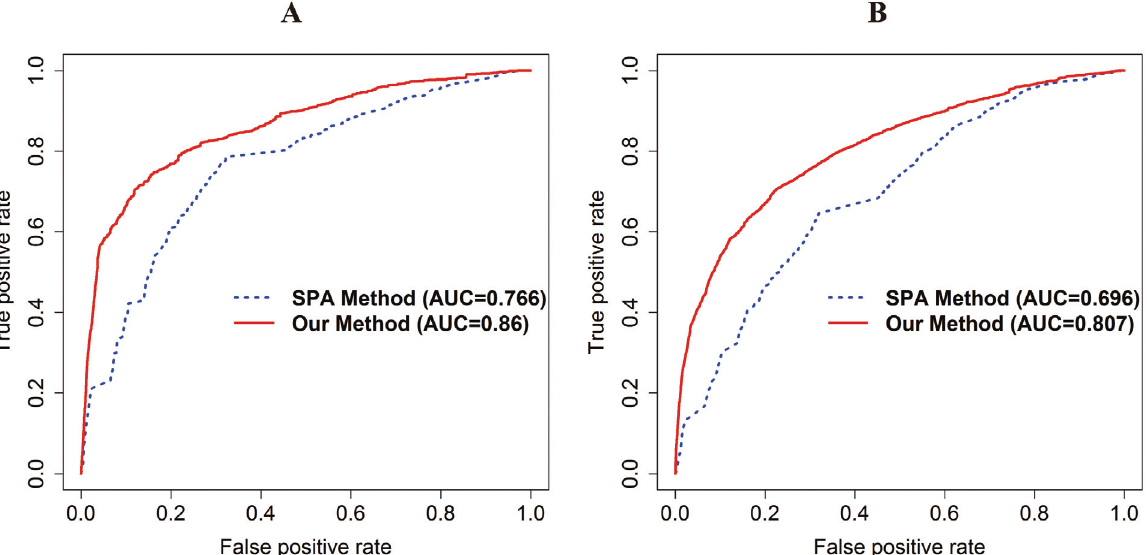
Fig 2. A receiver operating characteristic (ROC) curve with AUC in DrugBank and KEGG DRUG for comparison with the SPA method using integrated PPI network. The red and blue lines represent our method and the SPA method, respectively. (A) The ROC curve with the AUC of our method and the SPA method in DrugBank. (B) The ROC curve with the AUC of our method and the SPA method in KEGG DRUG. The AUC of our method and the SPA method in each DDI database are 0.86 and 0.766 in DrugBank, 0.807 and 0.696 in KEGG DRUG.